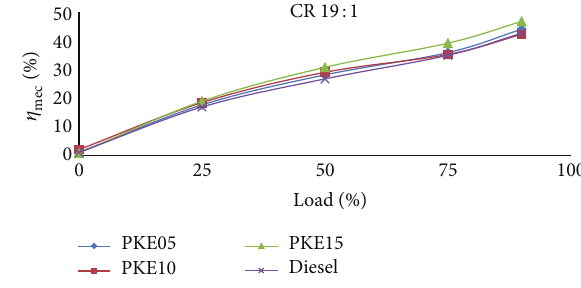
Figure 4: Load versus mechanical efficiency at 14: 1 CR.